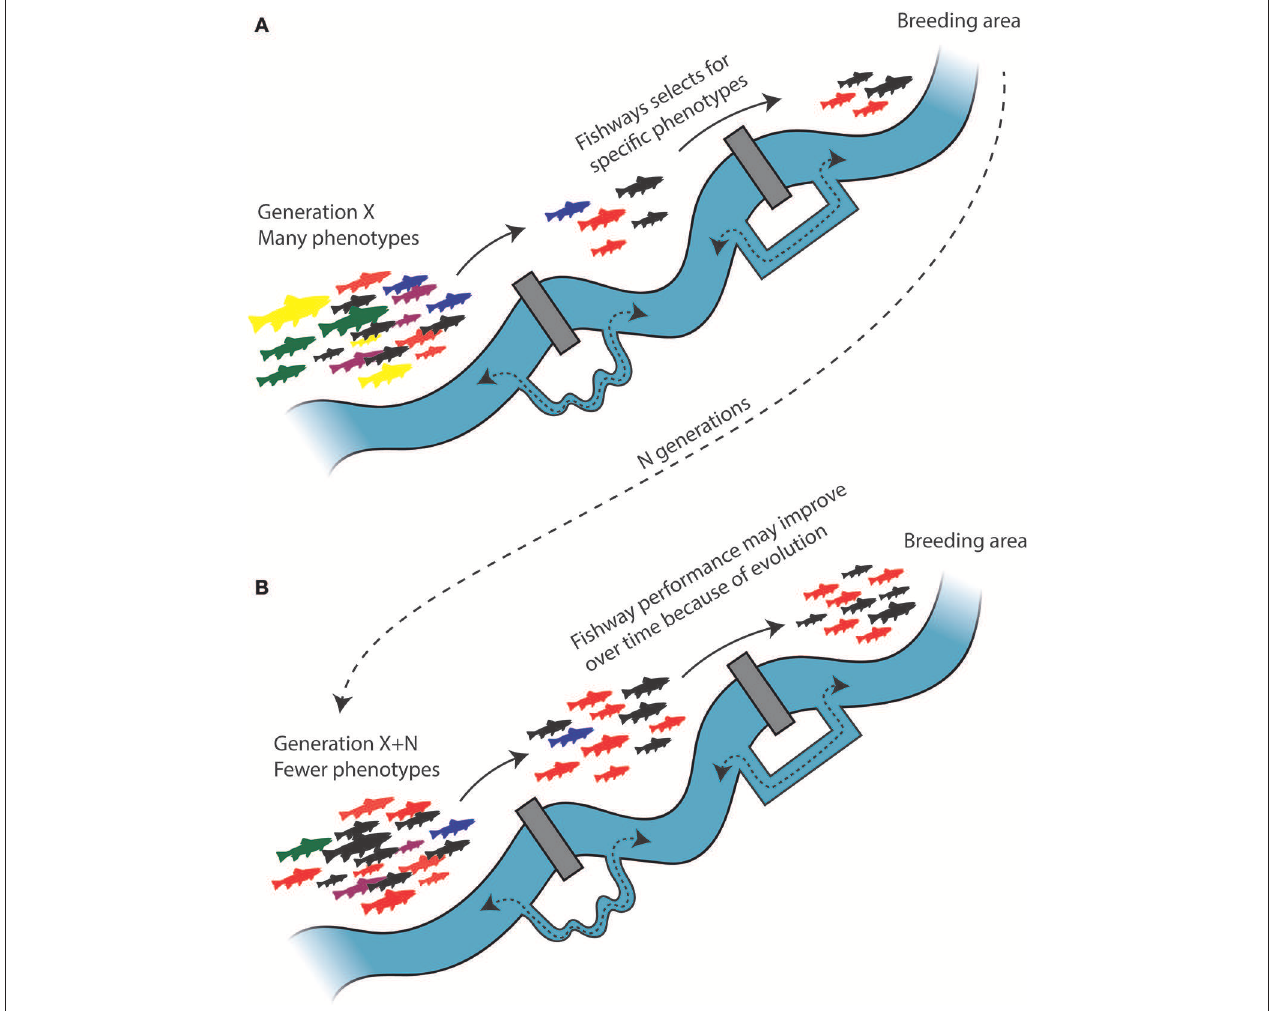
FIGURE 5 | Fishways impose selection and can induce evolutionary modifications of spawning migrating fish. (A) The spawning migrating fish have to pass two barriers equipped with fishways to arrive at the breeding area. Fishways are generally inefficient and can either relax selection or impose selection by favoring certain phenotypes (here represented by red and black) that are more proficient at traversing fishways, gradually reducing phenotypic diversity after each passage. Due to selection and spatial sorting, the breeding population will consist mostly of red and black phenotypes, and as a result of assortative mating the relative frequency of these phenotypes will increase and the phenotypic and genetic diversity in the population will decrease over time (N generations). (B) The increase in relative frequency of passage proficient phenotypes may, at least in theory, improve fishway performance. The loss of standing genetic variation, however, will reduce the adaptive potential, and viability of the